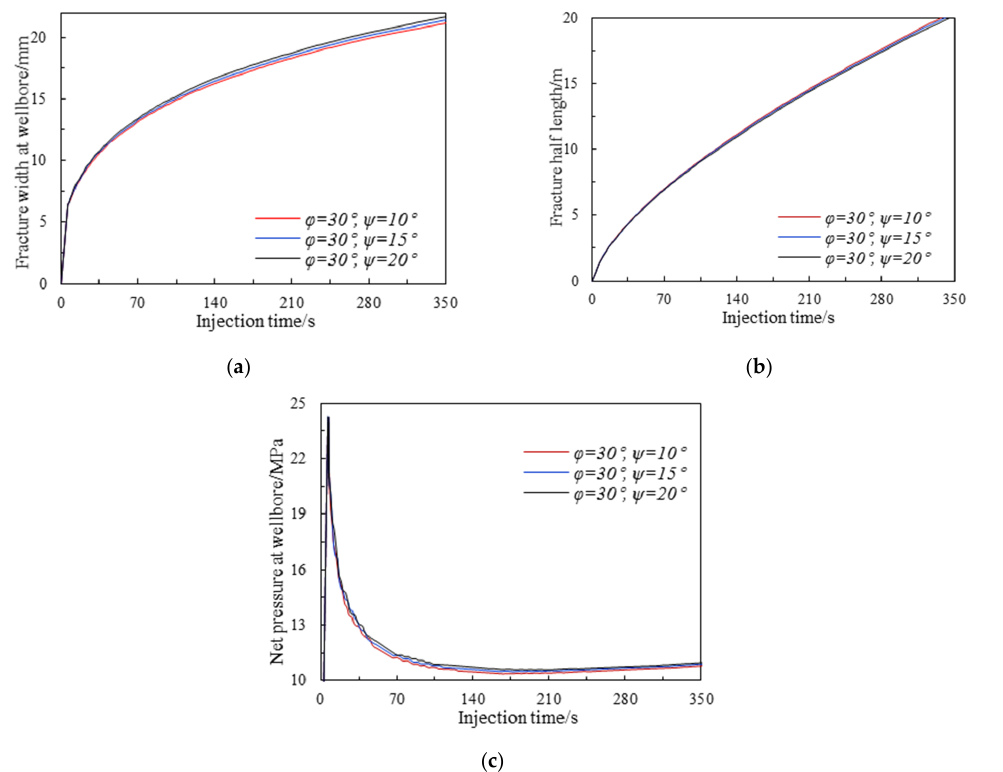
Figure 13. Numerical results with different dilatancy angles. ( a ) Fracture width at wellbore; ( b ) fracture half-length; and ( c ) net pressure at wellbore.